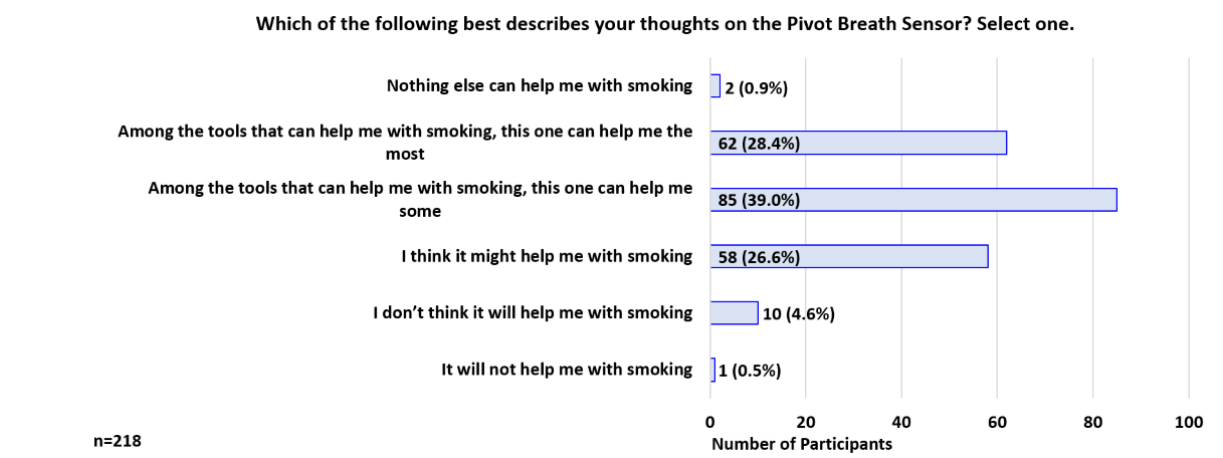
Figure 9. Participant Feedback: Thoughts on the Pivot Breath Sensor (week